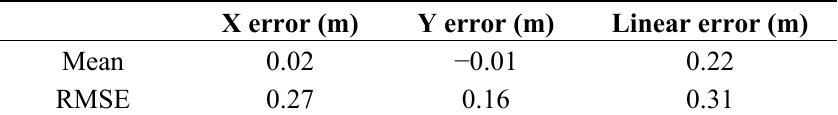
Table 5. Errors obtained in absolute coordinates of 22 traffic